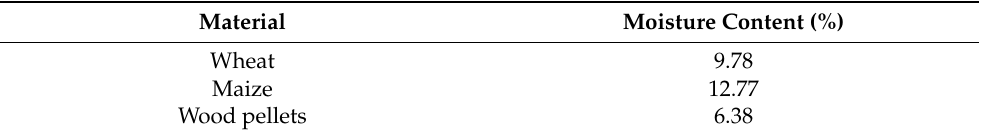
Table 8. Moisture content of the